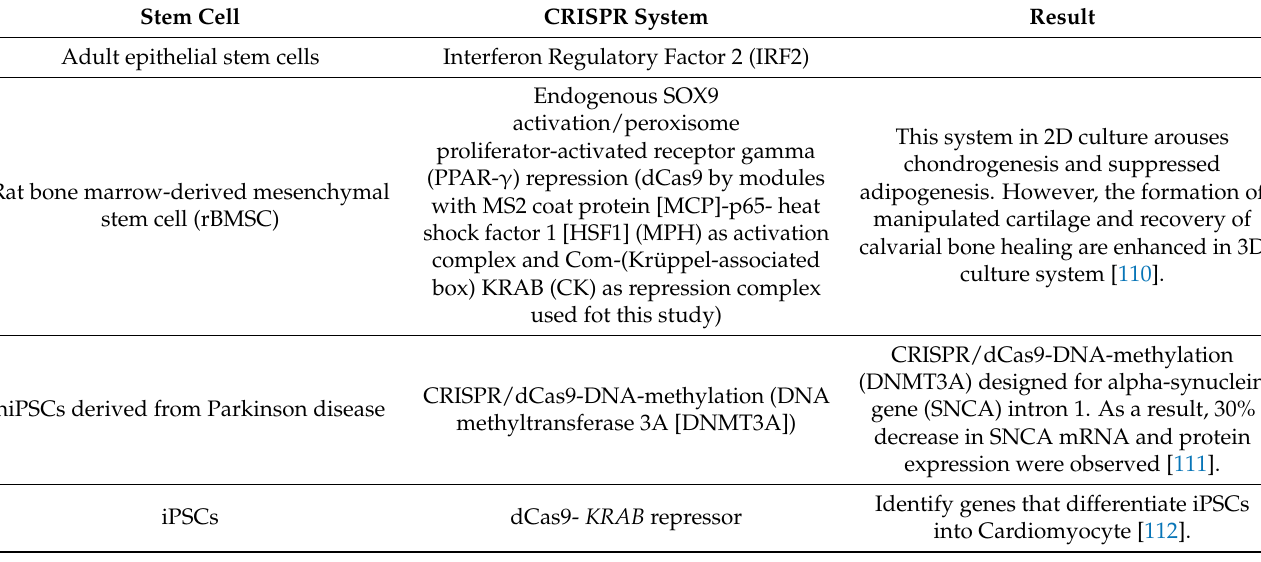
Table 2. The effect of CRISPR a/i on the gene expression regulation in the stem cell